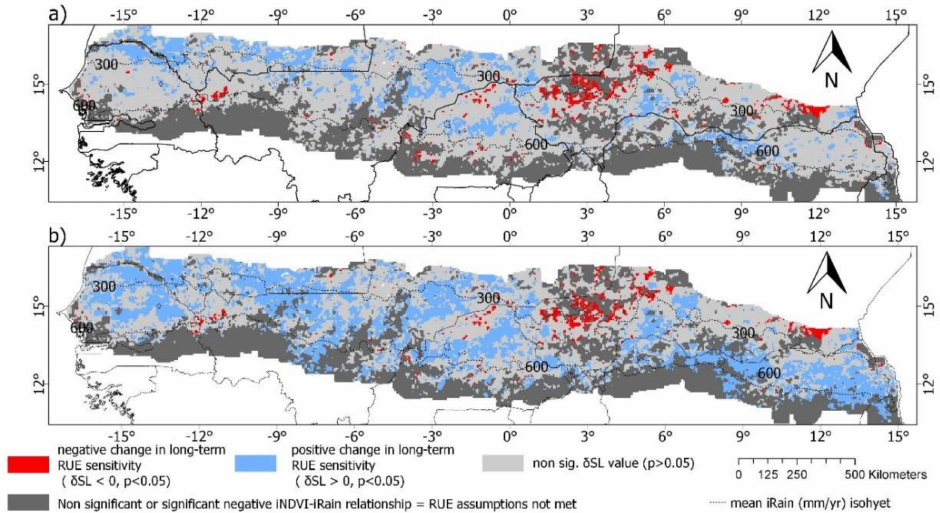
Figure 7. Inter-decadal change in long-term RUE sensitivity ( δ S L ): ( a ) assuming a linear i NDVI– i Rain relationship, ( b ) following AIC model-selection between linear and saturating relationships.